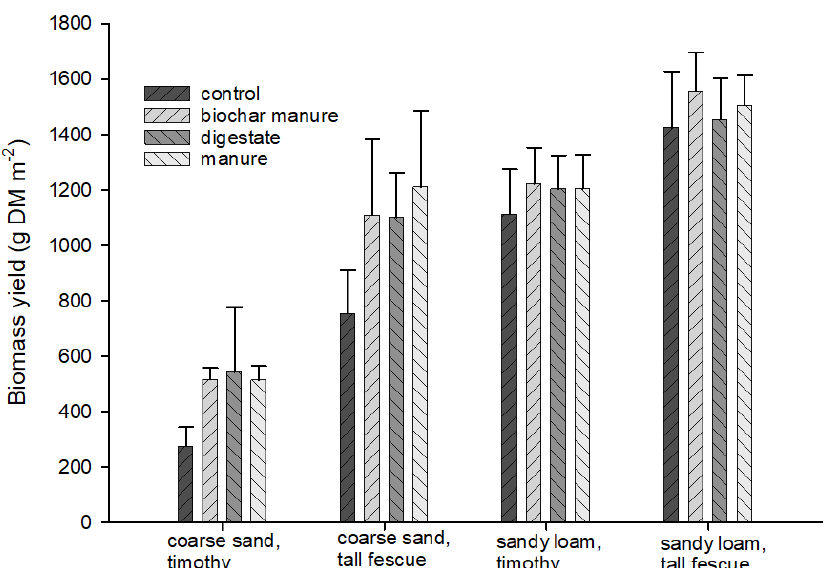
Fig. 1. Total seasonal dry matter yield of timothy and tall fescue on the two experimental soils at Særheim, Norway, in 2018. Error bars indicate 95% confidence